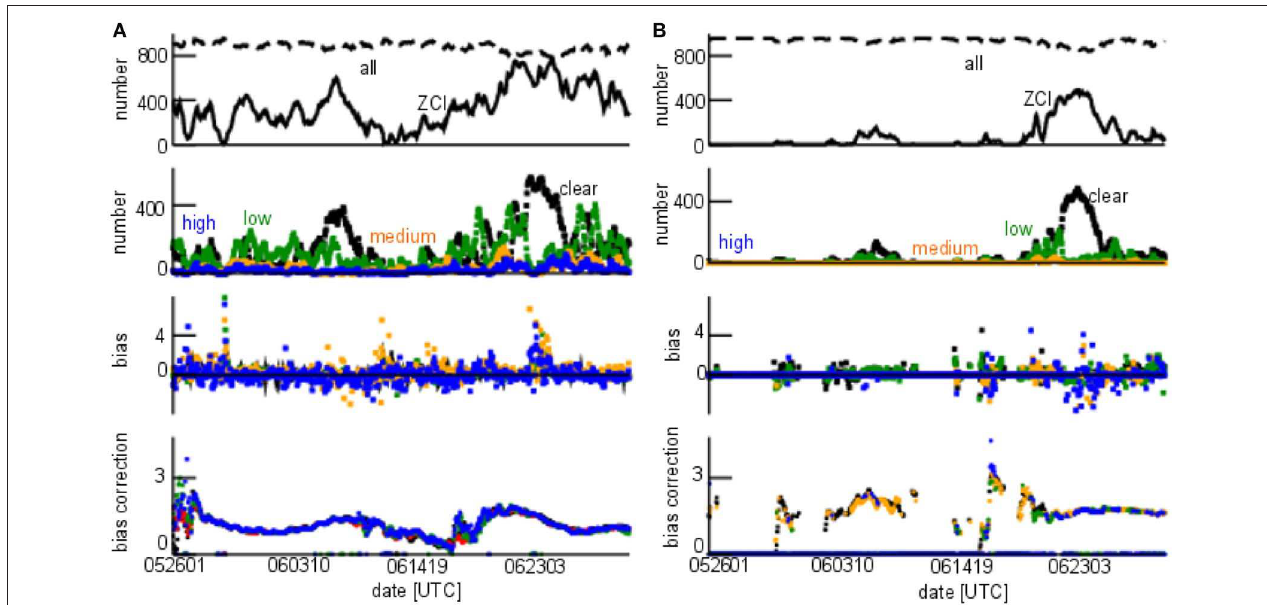
FIGURE 7 | Time series of statistics. (A) channel 6.2 µ m, (B) channel 7.3 µ m. First row from top: number of all available (dashed line) and ZCI observations (solid line). Second row: number of ZCI-observations for FOV’s diagnosed by NWC-SAF as clear-sky (black), low cloud (green), medium cloud (orange), and high cloud (blue). Third row: mean satellite observation—first guess departure (after bias correction) for each cloud type. Bottom row: online bias correction of observations for each cloud type. The date is given in format mmddhh with month mm , day dd and hour hh . Data shown from second to bottom row are based on